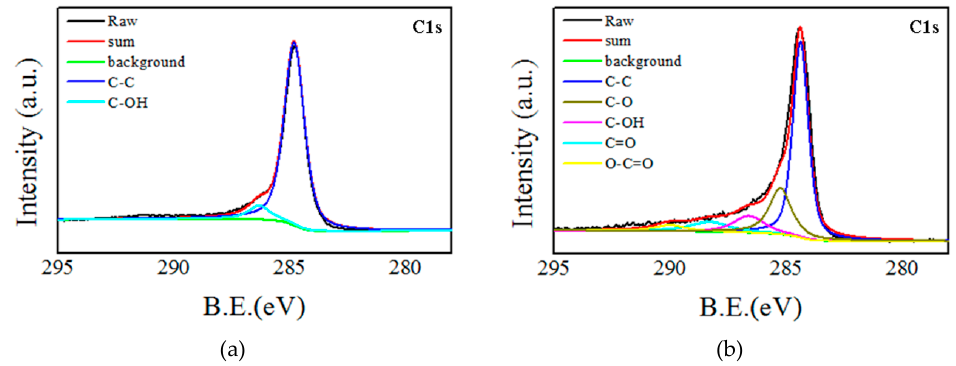
Figure 6. Typical XPS spectra of recovered samples. ( a ) C 1s spectrum of Sample No. 1 and ( b ) C 2s spectrum of Sample No. 2.